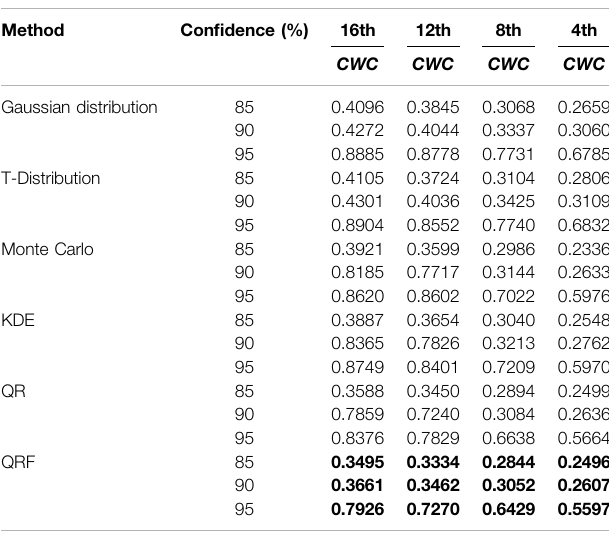
TABLE 5 | CWC at different con fi dence levels for each time